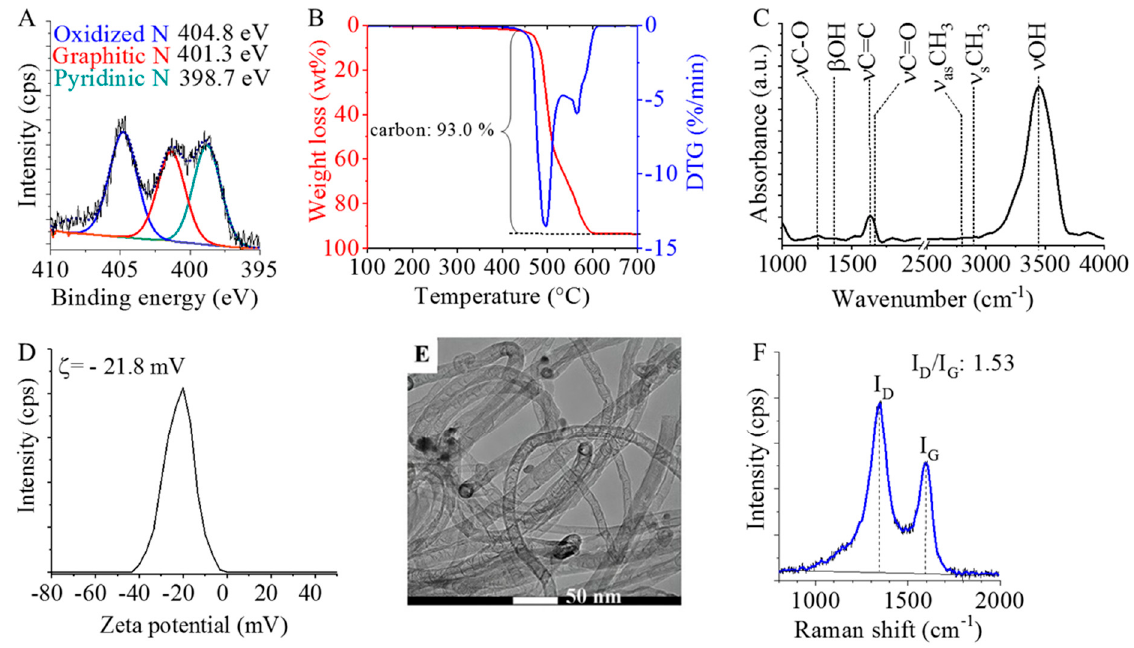
Figure 3. Characterization of the prepared N-BCNTs. XPS spectrum ( A ), TGA–DTG curves ( B ), FTIR spectrum ( C ), zeta potential distribution ( D ), TEM image ( E ), and Raman spectra with the D-peak and G-peak ( F ).